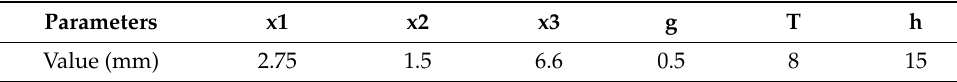
Table 1. parameters of the NRMS. Table 1. Parameters of the